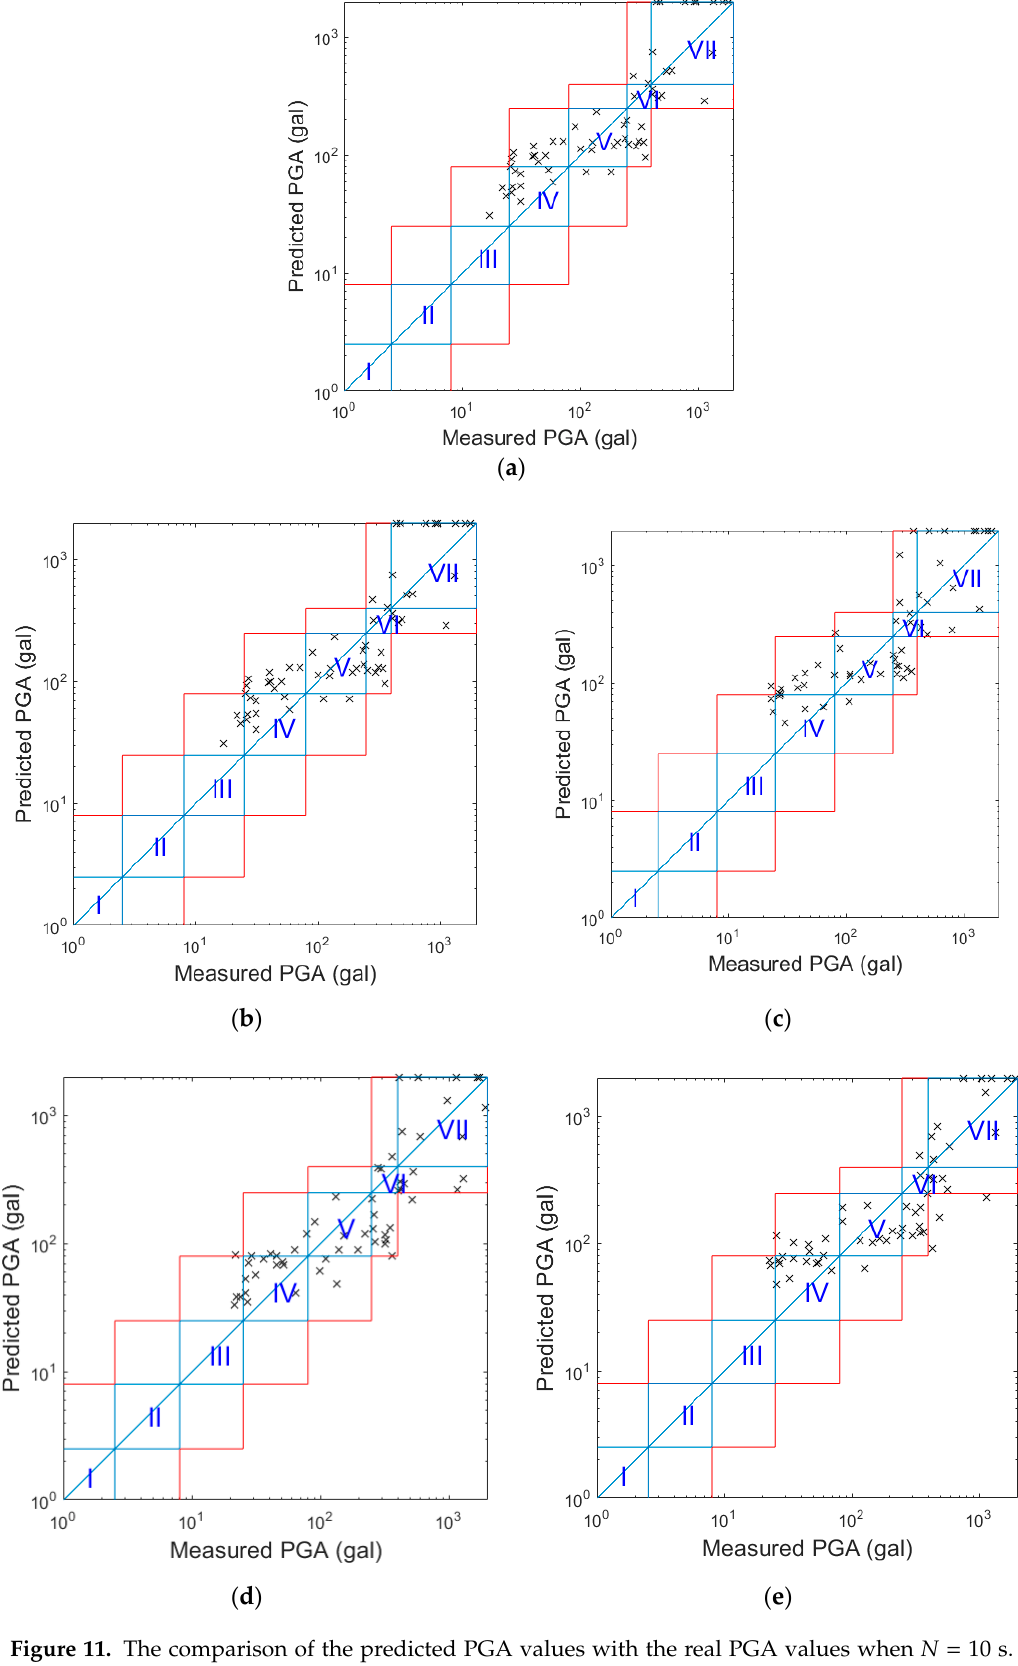
Figure 11. The comparison of the predicted PGA values with the real PGA values when N = 10 s. ( a ) LG Stylus; ( b ) Asus ZenFone Selfie; ( c ) HTC Desire Eye; ( d ) Redmi Note4; ( e ) Huawei P3.